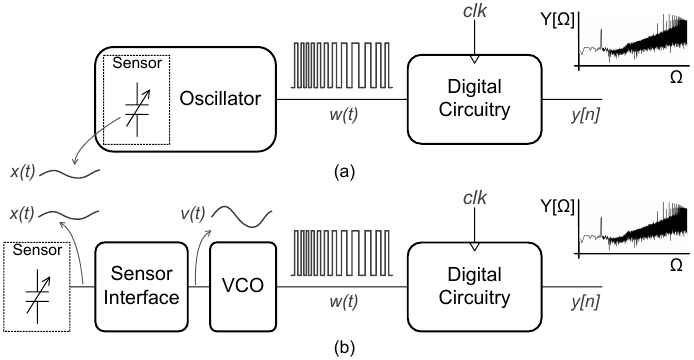
Figure 1. Oscillator-based analog-to-digital converter (ADC) for capacitive Microelectromechanical systems (MEMS) sensors: ( a ) Sensor connected as the load of an oscillator; ( b ) sensor connected via an analog